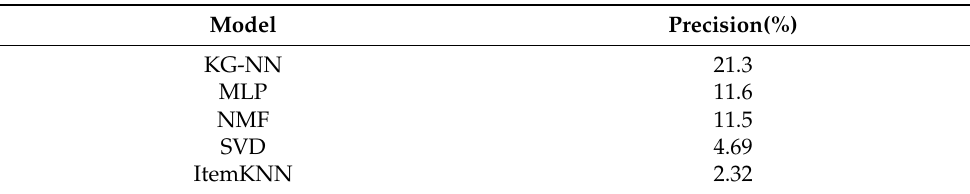
Table 8. Comparison experiment